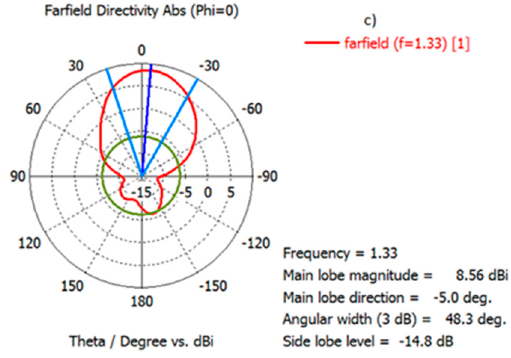
Figure 13. Results obtained with FR-4 for − 5°.